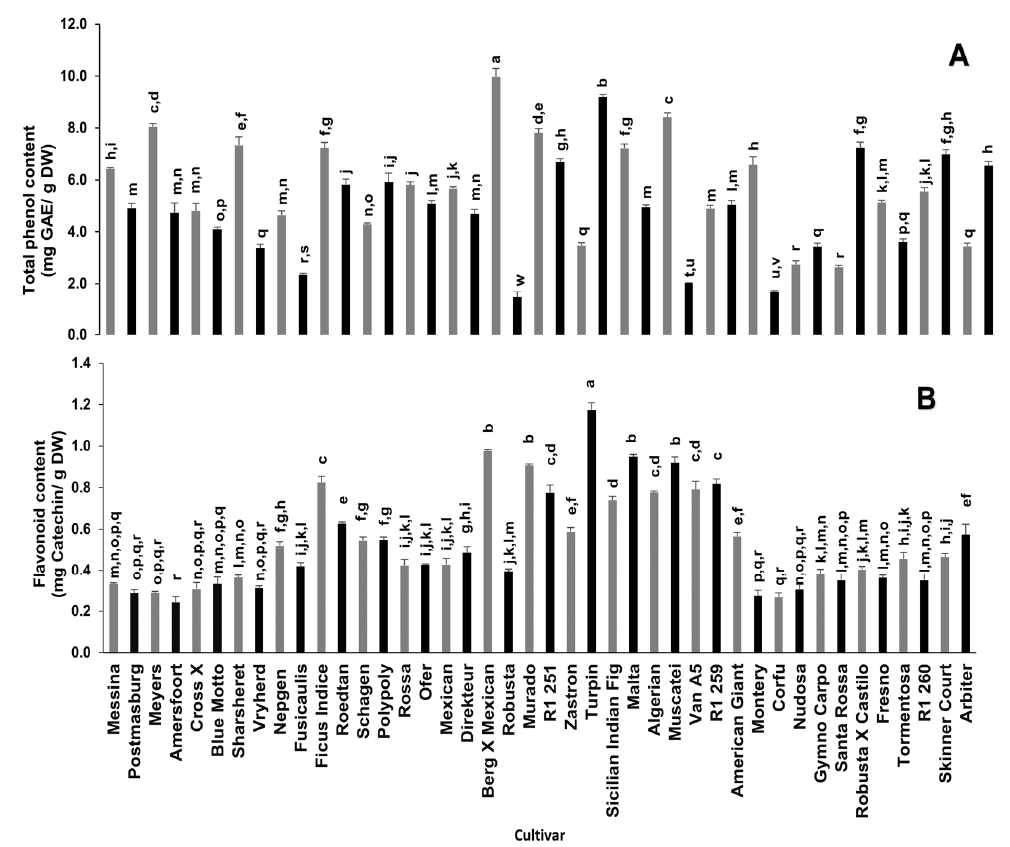
Figure 1. Total phenolic ( A ) and flavonoid ( B ) contents of cladodes from 42 spineless cactus pear cultivars. Bars bearing different letters in each graph are significantly different ( p = 0.05) according to Duncan’s Multiple Range Test (DMRT). Values are mean ± standard errors (n = 3). GAE—Gallic Acid